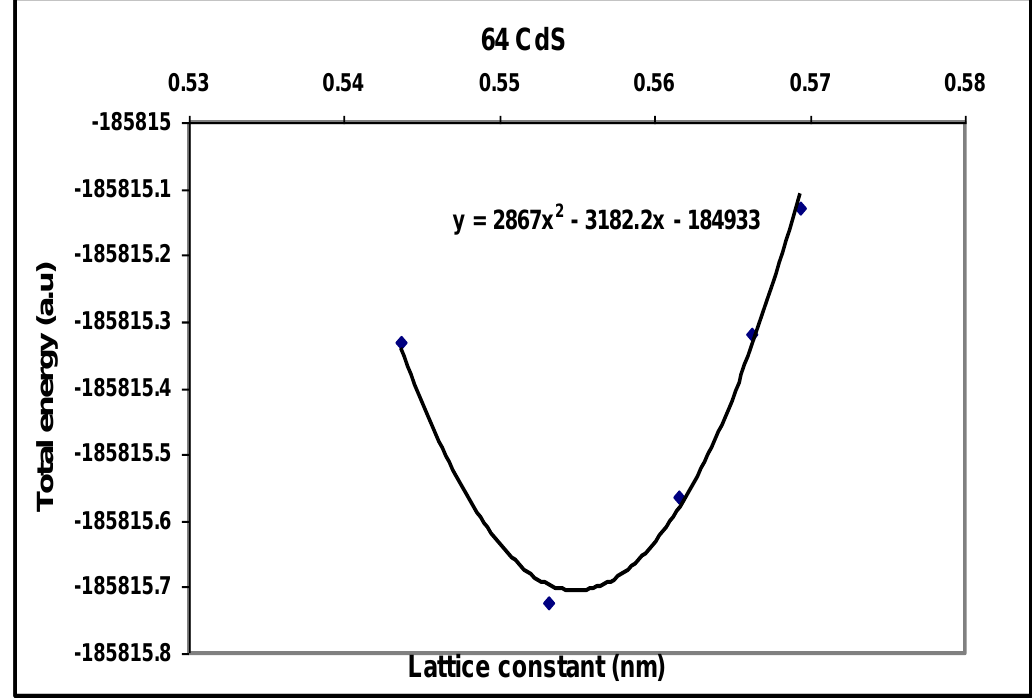
Fig.4: Total energy of 64 atoms of CdS nanocrystal core as a function of lattice